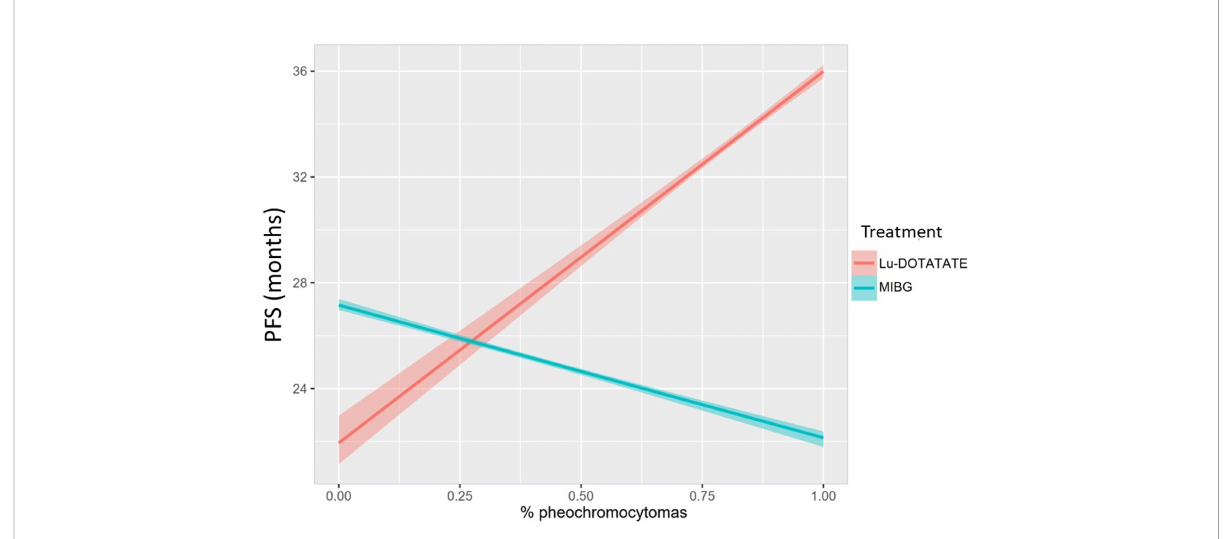
FIGURE 4 Conditional effects plot depicting the interaction between treatment and proportion of PHEOs in the sample regarding the estimated PFS in